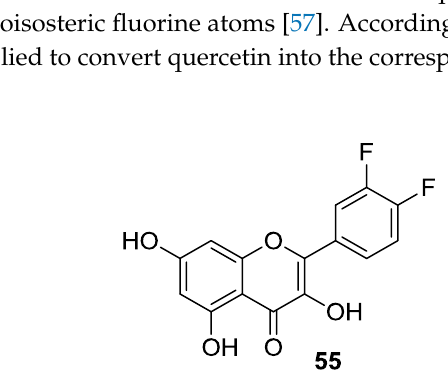
Figure 8. Structures of O -acylated quercetin derivatives 56 – 63 .